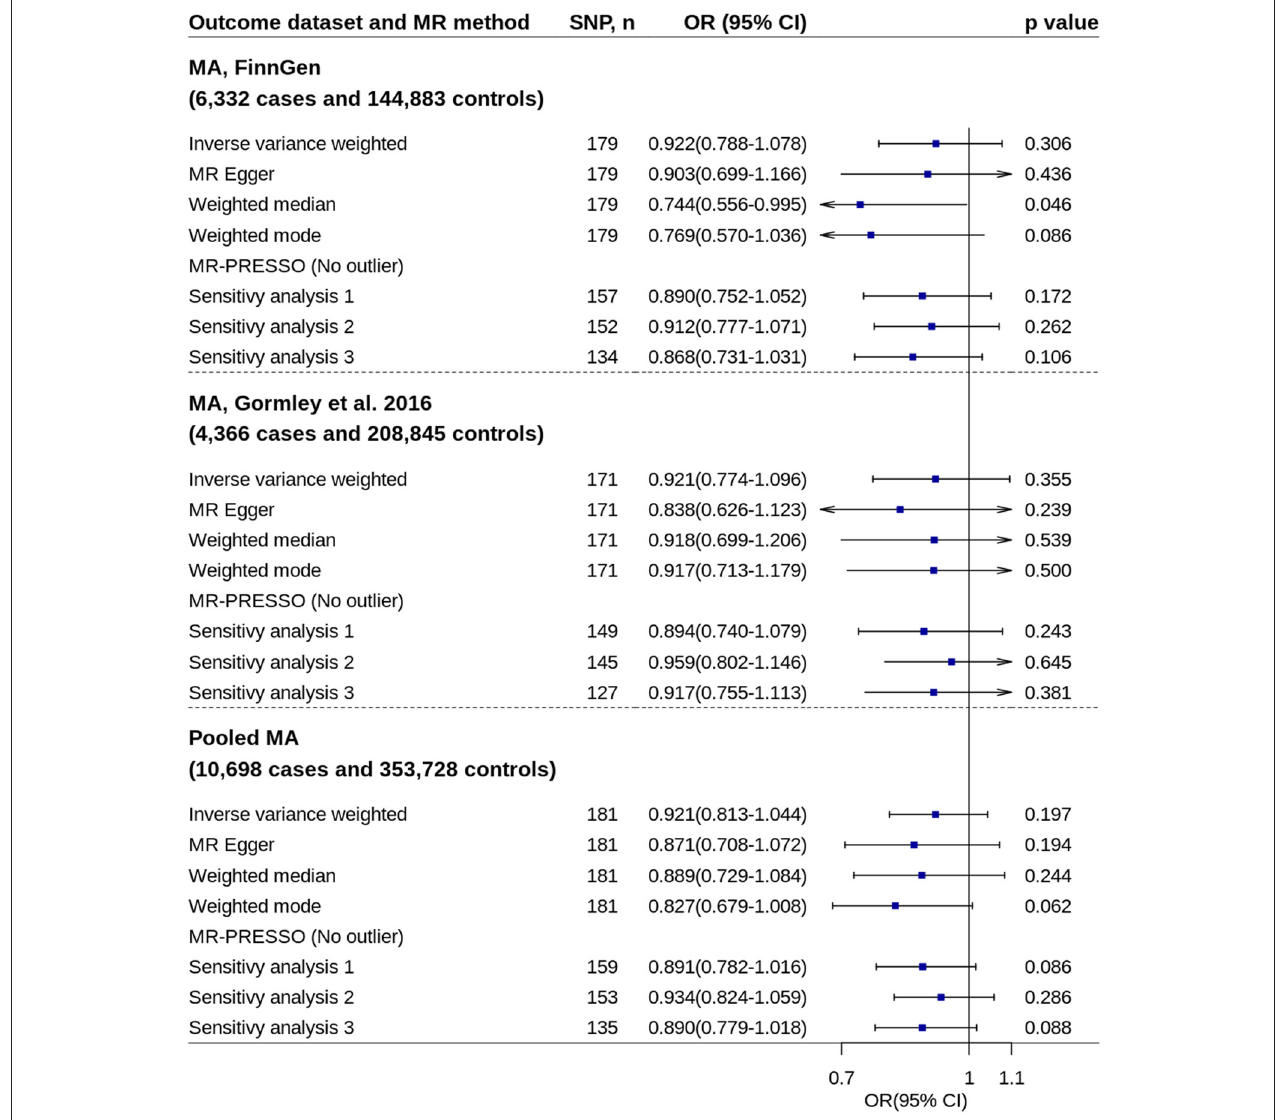
FIGURE 5 | Mendelian randomization analyses of 25OHD on risk of migraine with aura. Sensitivity analysis 1: SNPs associated with potential confounders were excluded. Sensitivity analysis 2: Potential reverse causal SNPs were excluded (Steiger-filtered analysis). Sensitivity analysis 3: All SNPs excluded in sensitivity analysis 1 and sensitivity analysis 2 were excluded. 25OHD, 25-hydroxyvitamin D; CI, confidence interval; MA, migraine with aura; MR, Mendelian randomization; MR-PRESSO, MR-Pleiotropy Residual Sum and Outlier; OR, odds ratio; SNP, single nucleotide polymorphism.